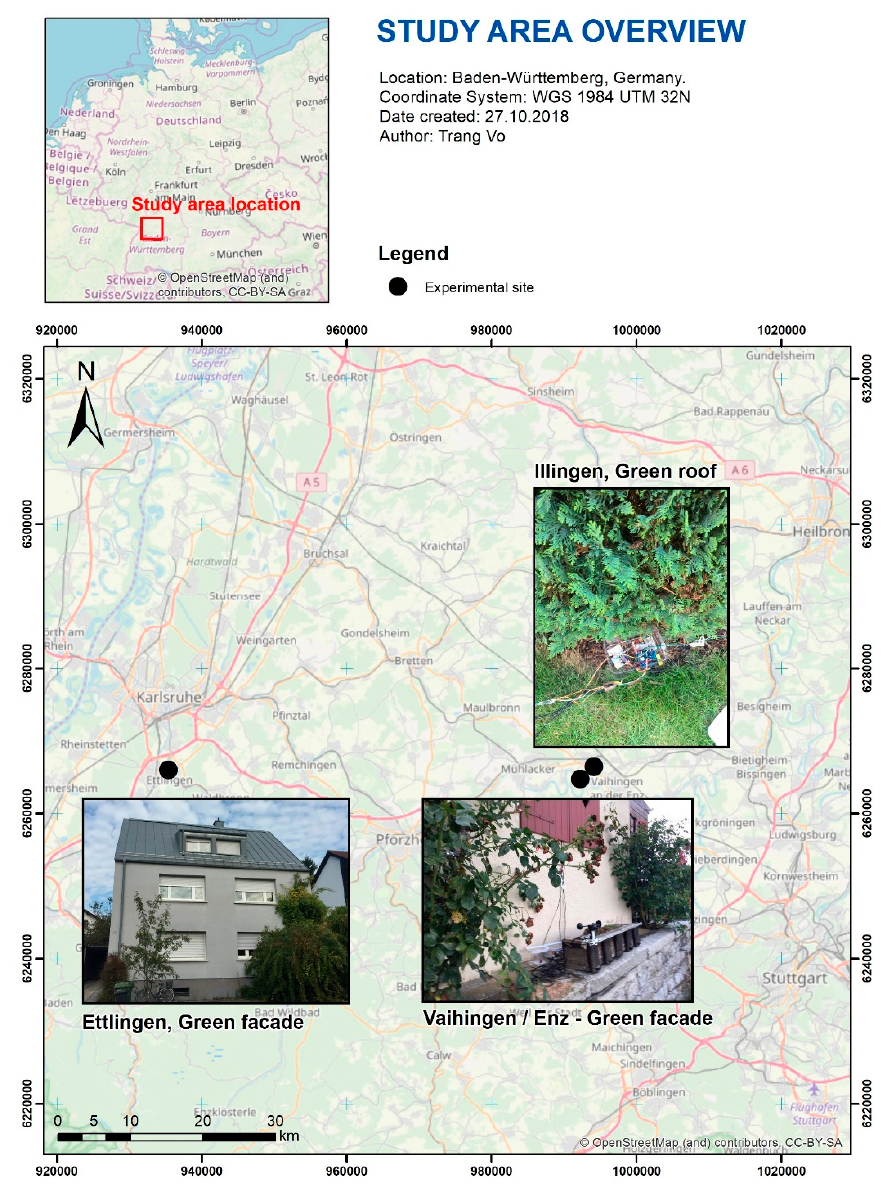
Figure A1. Map of the study area and location of experimental sites. The red dots illustrated the position of the three study sites.